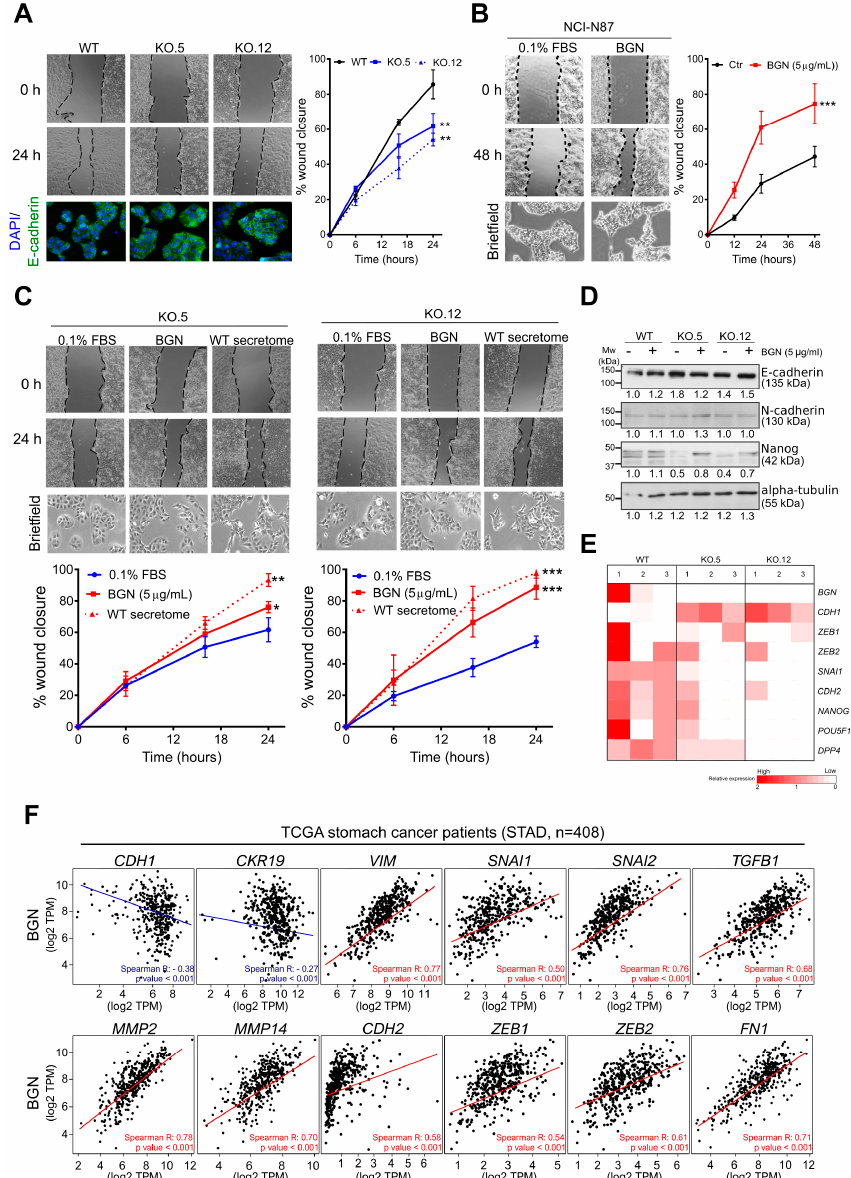
Figure 4. Biglycan modulates GC cell migration through the regulation of epithelial-mesenchymal (EMT) markers. ( A ) Wound-healing migration assay in MKN74 WT and in biglycan KO cells. The loss of biglycan decreases cell migration capacity with a concomitant increase of E-cadherin (bottom images, magnification at 200×). ( B ) Treatment with 5 μ g/mL of commercial purified biglycan is able to increase cell migration in the NCI-N87 biglycan-negative cell line. Exogenous biglycan is also able to promote a mesenchymal-like phenotype with more elongated spindle-like cells. Images magnification at 200× ( C ) Migration capacity of biglycan KO cells upon exogenous treatment with commercial purified biglycan or secretome from MKN74 WT (biglycan positive). Both treatments are able to restore migration capacity of KO cells and to promote a mesenchymal-like phenotype of cells. Images magnification at 200 × ( D ) Western blot analysis of epithelial (E-cadherin) and mesenchymal (N-cadherin and Nanog) markers with or without biglycan treatment. ( E ) Expression levels of epithelial markers ( CDH1 or E-cadherin ) as well as mesenchymal markers ( CDH2 or N-cadherin , SNAI1, ZEB1, ZEB2, NANOG, POU5F1, and DPP4 ) were examined by qRT-PCR. Biglycan KO cells present increased expression of CDH1 and decreased expression in mesenchymal markers such as CDH2 , SNAI1, and ZEB2 . Three independent analysis were performed in duplicate. ( F ) In silico analysis of epithelial and mesenchymal genes in human stomach cancer samples (STAD-TCGA, n = 408) using the Gene Expression Profiling Interactive Analysis (GEPIA) program corroborating the in vitro findings. In vitro data are presented as the mean ± standard error of the mean (S.E.M.) of at least three independent experiments. *, p value < 0.05; **, p value < 0.01; ***, p value <